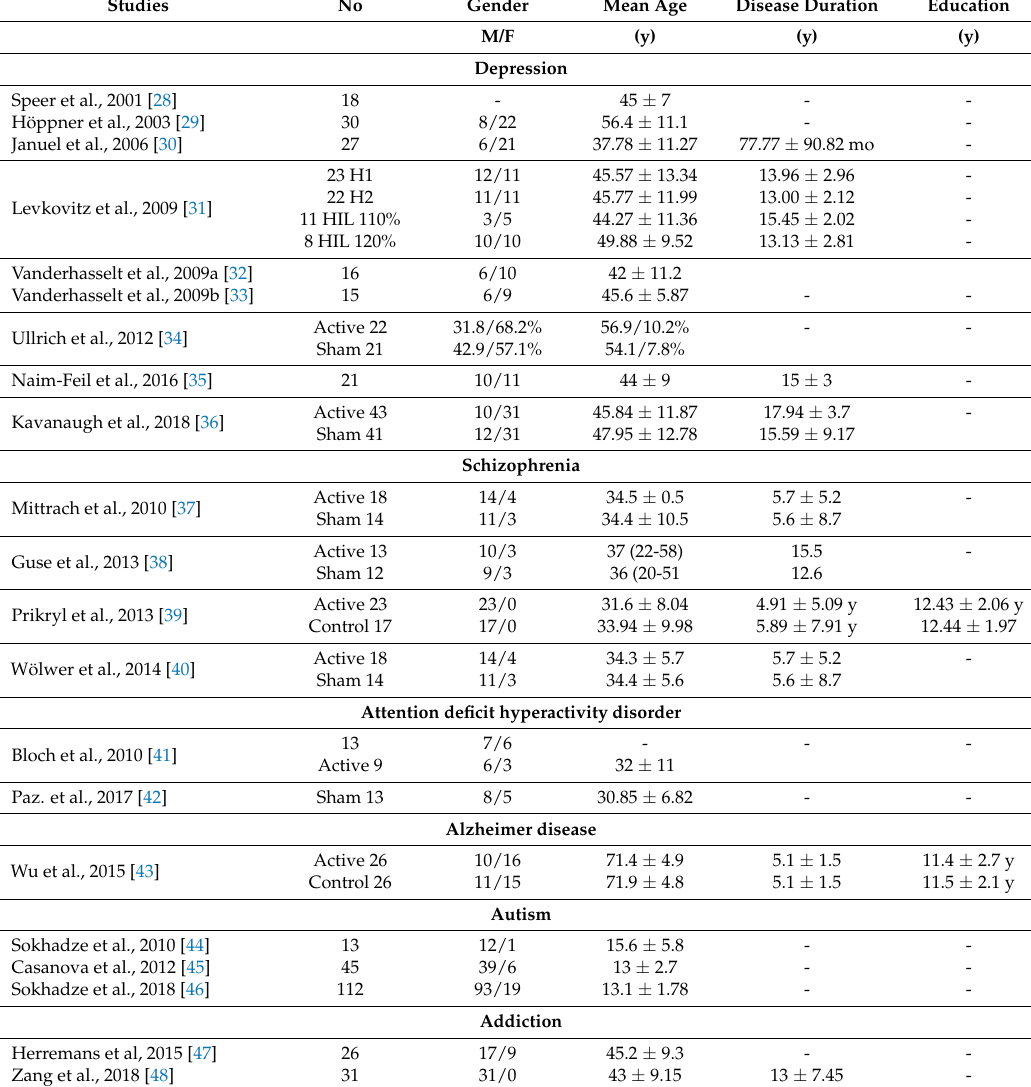
Table 1. Demographic characteristics of the patients in the included studies.